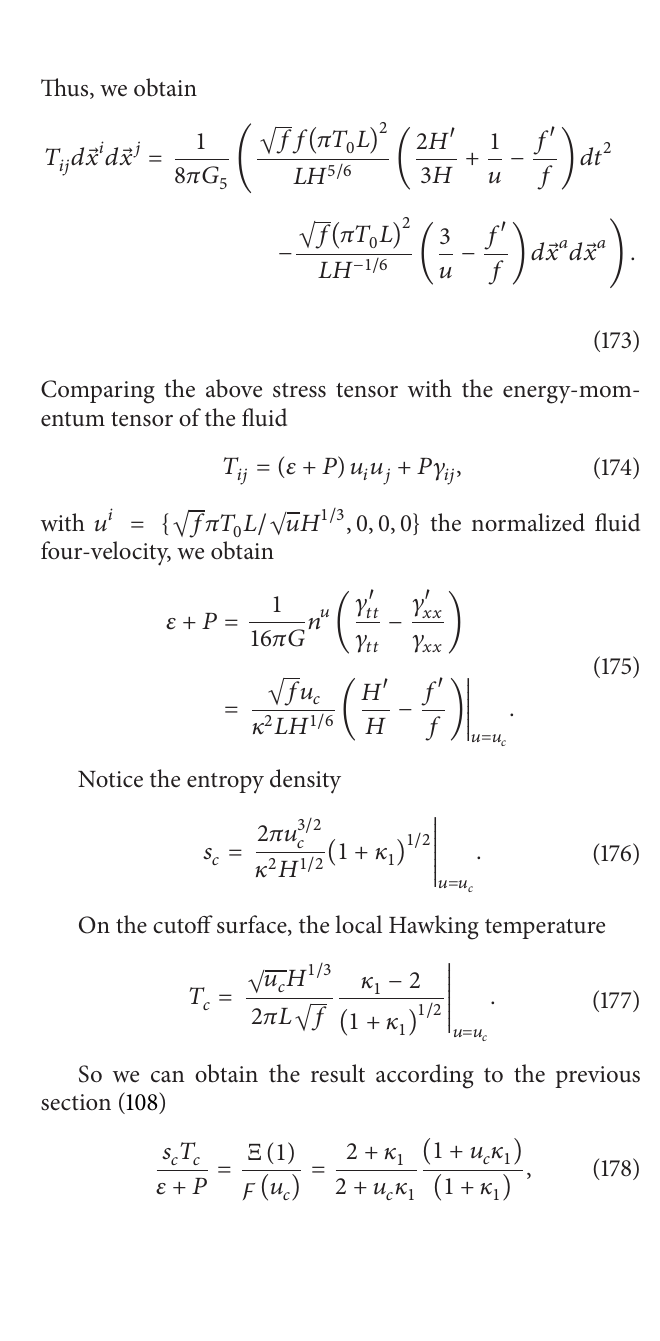
Figure 4: The dimensionless diffusion coefficient of single charge runs on the cutoff surface with different charges. The dashed line corresponds to the chargeless